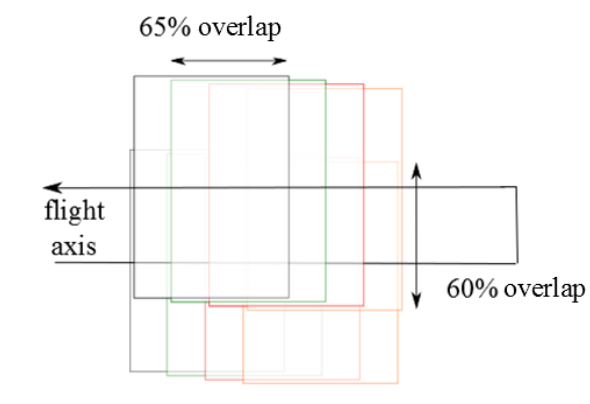
Figure 5. Representation of overlap from